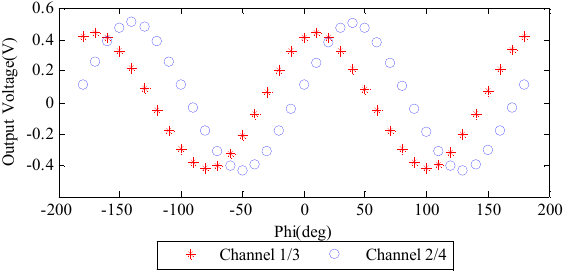
Figure 5. The output voltage of the two sets of orthogonal paths. The horizontal axis ‘Phi’ represents the AOP ( φ ) of incident